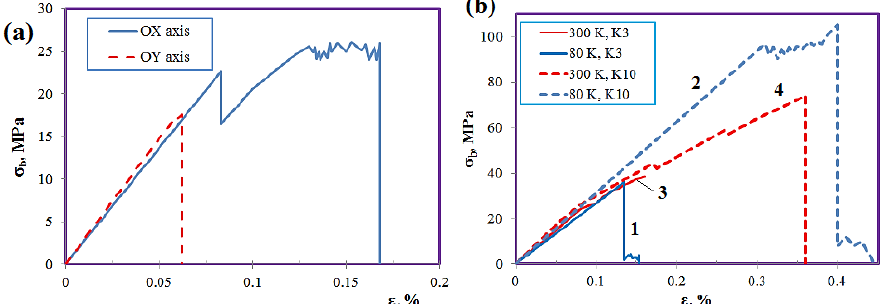
Figure 8. Stress–strain curves for Bi 0.91 Sb 0.09 single crystals ( a ) and extruded polycrystalline material ( b ) at different temperatures and extrusion ratios. ( a ) Bending force direction is perpendicular to the trigonal axis OZ and along the binary axis OX and the bisectrix OY axis ( F b || <101 > and F b || <121>, respectively); 200 K. ( b ) K e of 3 and 10 (solid and dashed lines, respectively); 80 K (1, 2) and 300 K (3,